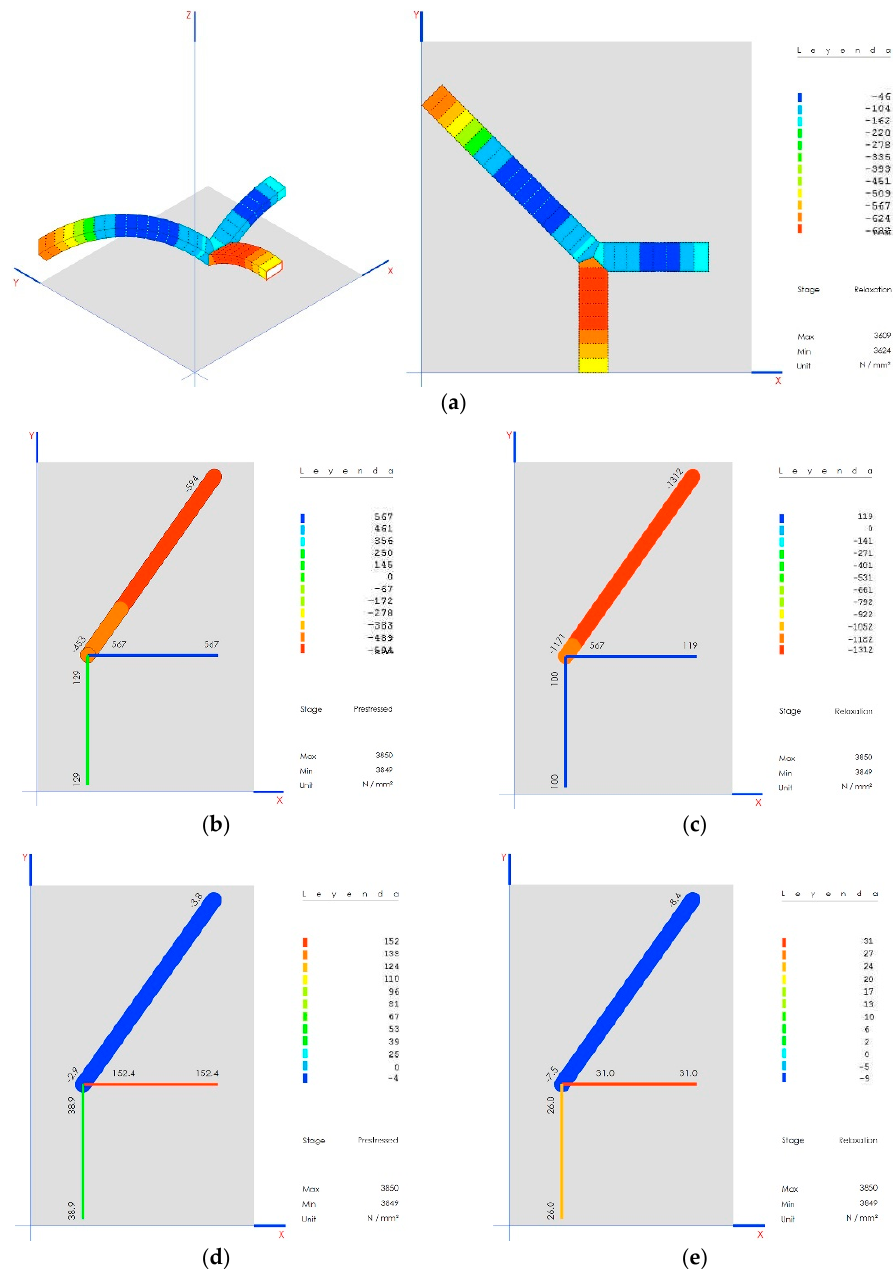
Figure 19. ( a ) The stability of the structure is guaranteed between 45 kN and the 624 kN because in that range the arches work in compression completely; ( b ) construction phase of prestressing; ( c ) final construction phase; ( d ) elastic limit in the prestressing phase of construction; ( e ) elastic limit in final construction phase.